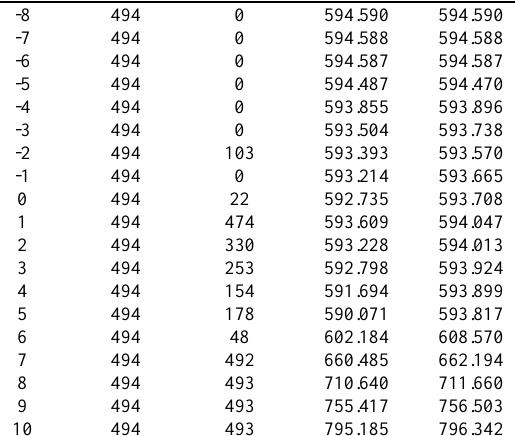
Figure 9. Energy Remaining after 500 seconds for Transmission Powers -10 dB to +10 dB.